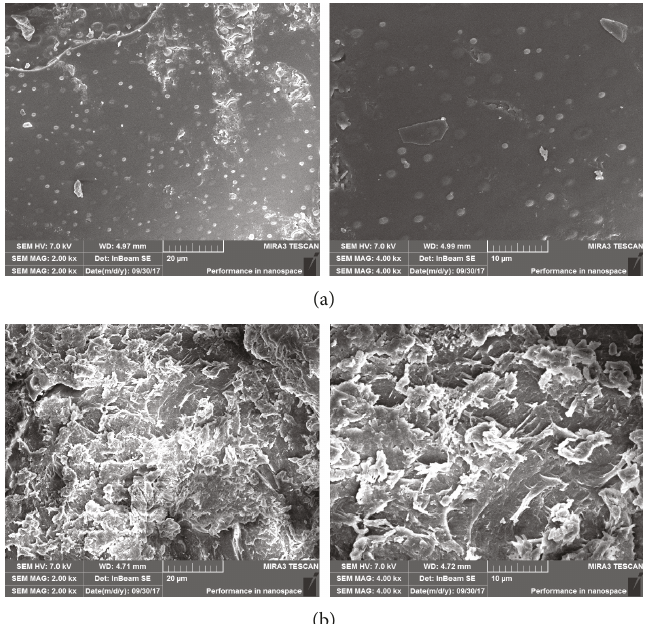
Figure 11: The images of (a) PAM and (b)